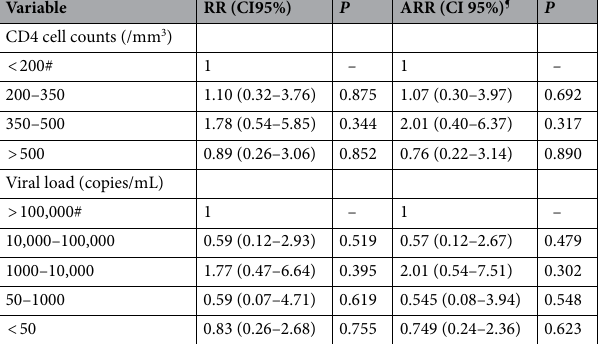
Variable RR (CI95%)